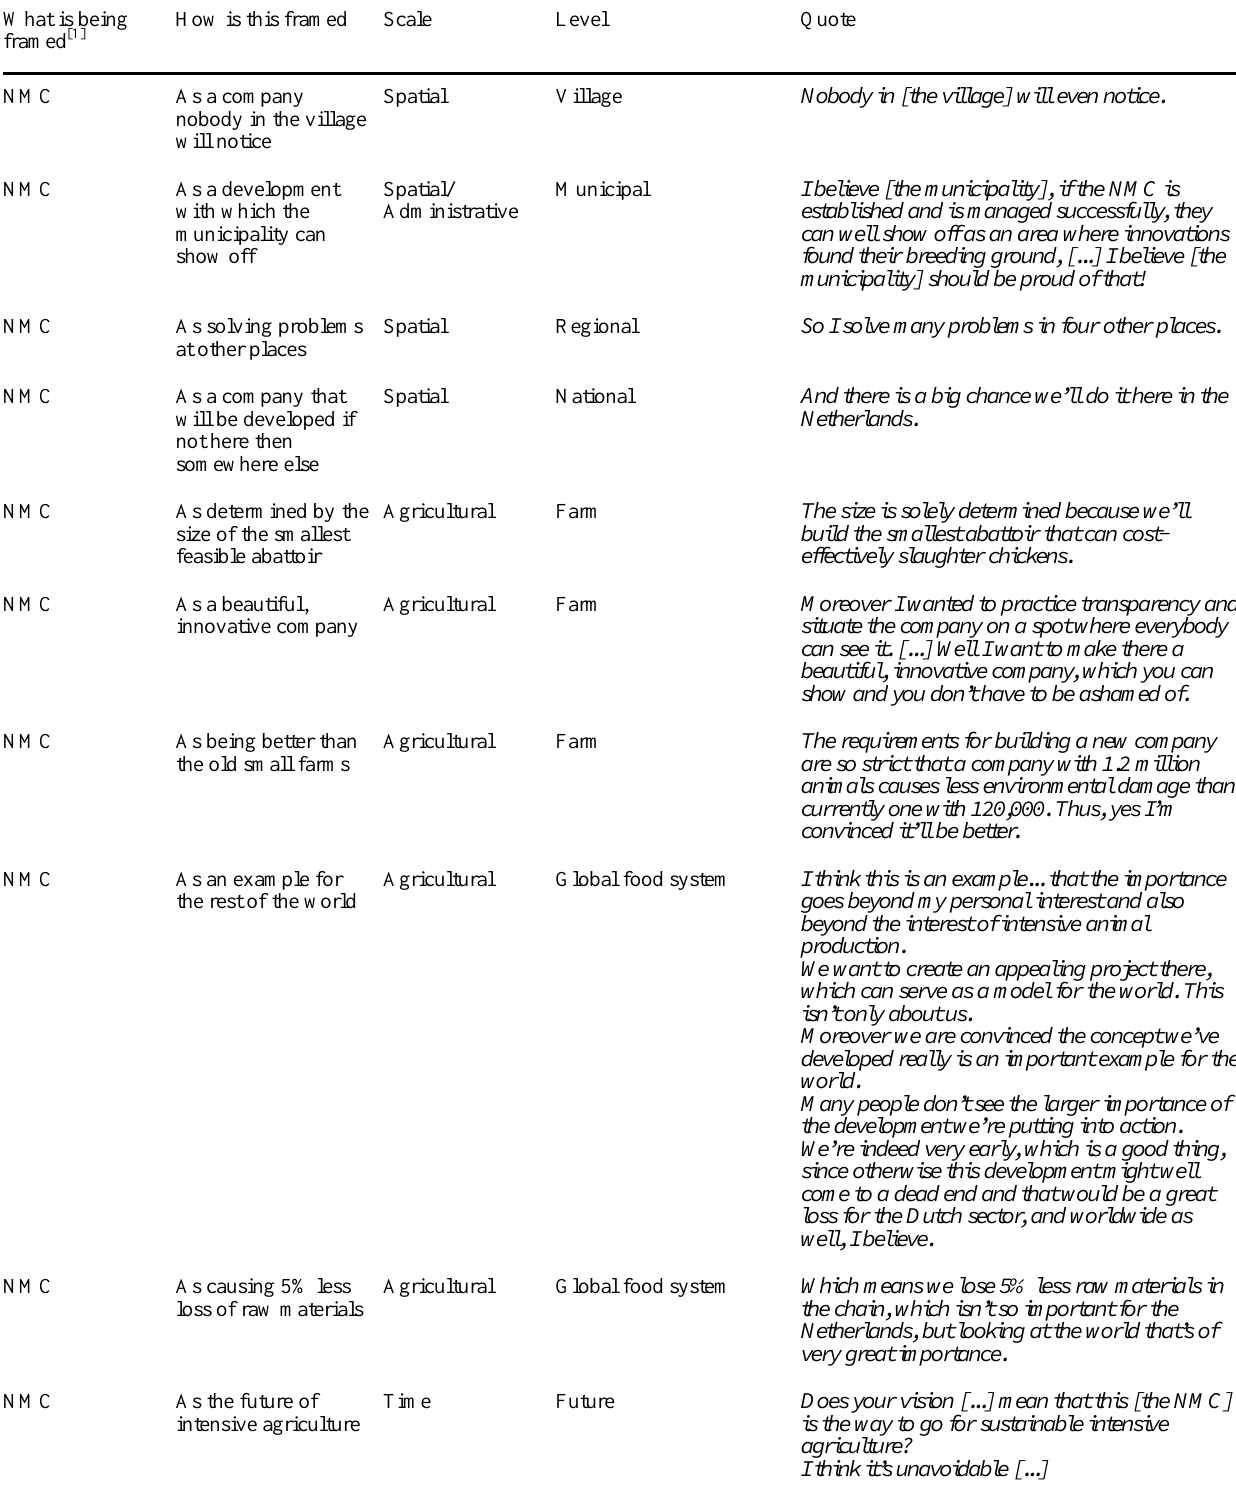
Table 4. The scales and levels used by the entrepreneur. What is being framed